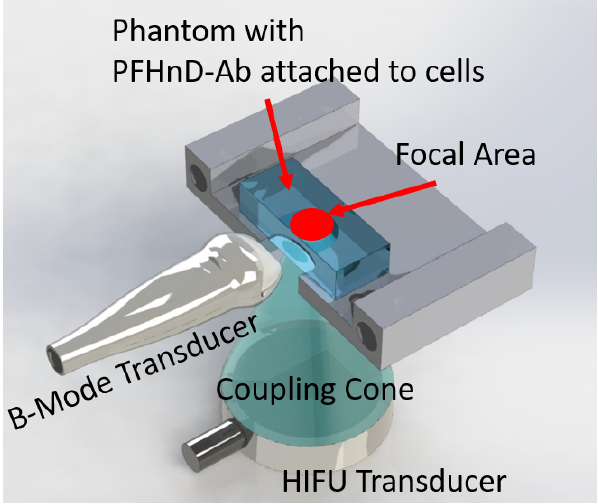
Figure 2. Schematic of the custom ultrasound setup. The single element HIFU transducer uses a polyacrylamide coupling cone to deliver the activation energy needed to induce the PFHnD-Ab phase change. Polyacrylamide phantoms containing PFHnD-Abs conjugated to cells were placed on the 3D printed stage. A linear array B-mode transducer was placed perpendicular to the activation plane to capture the vaporization and recondensation